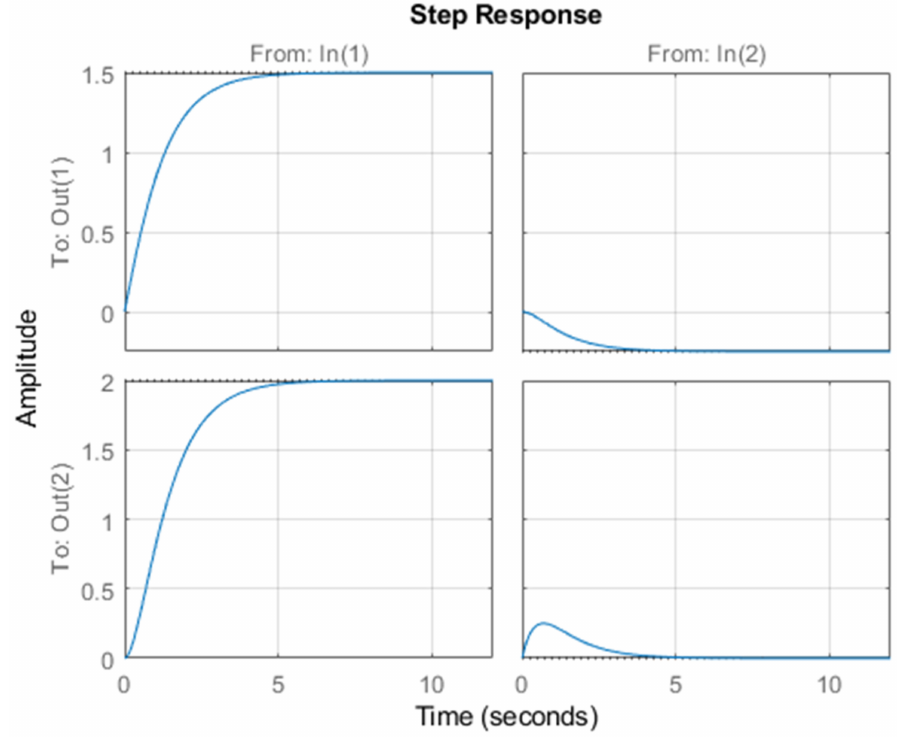
Figure 2. Closed loop system unit-step response due to an alternative set of eigenvectors. Using (20), which is related to the adjugate